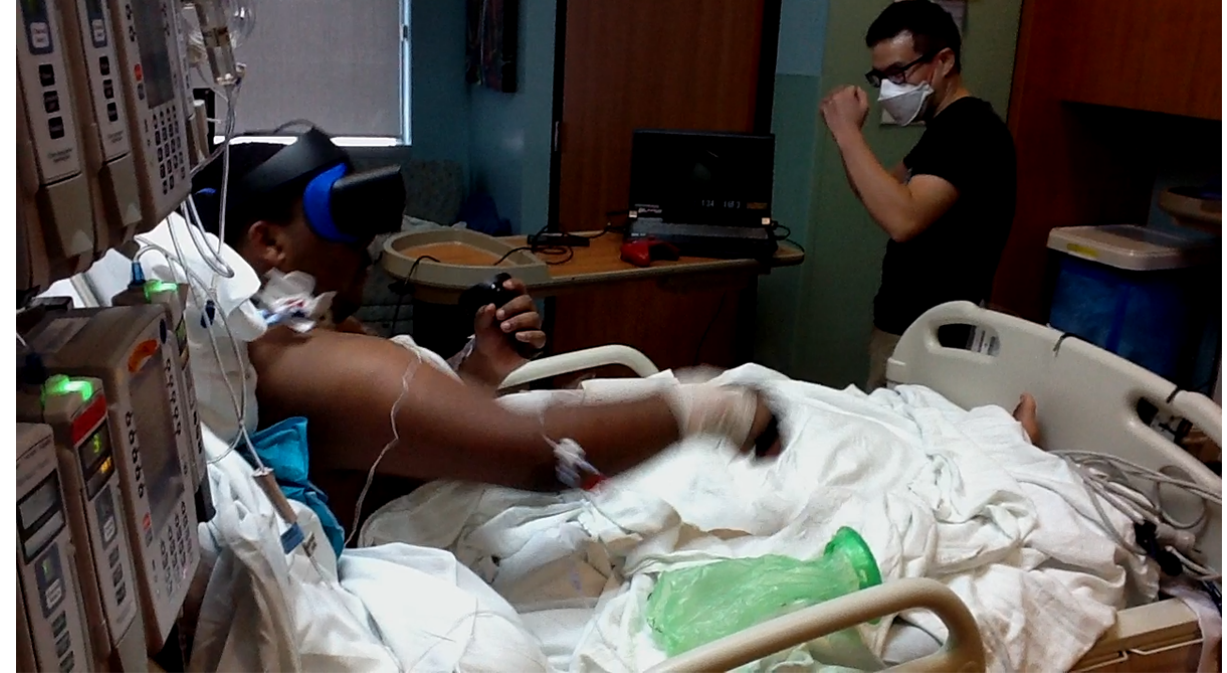
Figure 4. Demonstration of virtual reality boxing in the pediatric intensive care